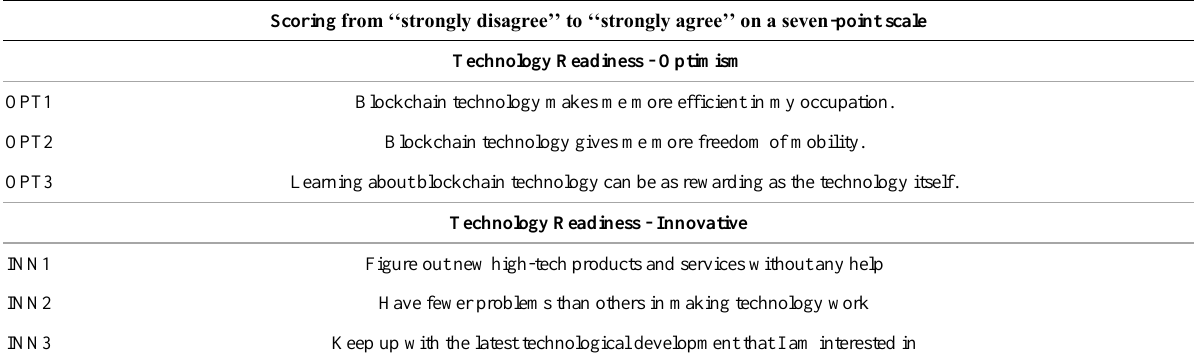
Table 3. Measurement items of